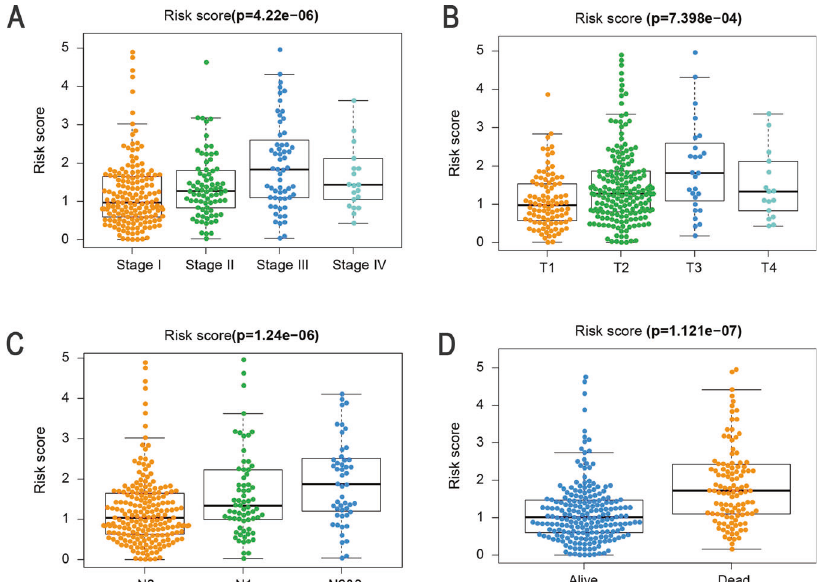
Fig. 5 FerRLSig was associated with the clinicopathological features of patients with LUAD. A Ferroptosis-related lncRNAs in the cohorts strati fi ed by tumor stage ( P < 0.001). B Ferroptosis-related lncRNAs in the cohorts strati fi ed by tumor size ( P < 0.001). C Ferroptosis-related lncRNAs in the cohorts strati fi ed by regional lymph nodes ( P < 0.001). D Ferroptosis-related lncRNAs in the cohorts strati fi ed by survival outcome ( P < 0.001). T, tumor size; N, regional lymph node